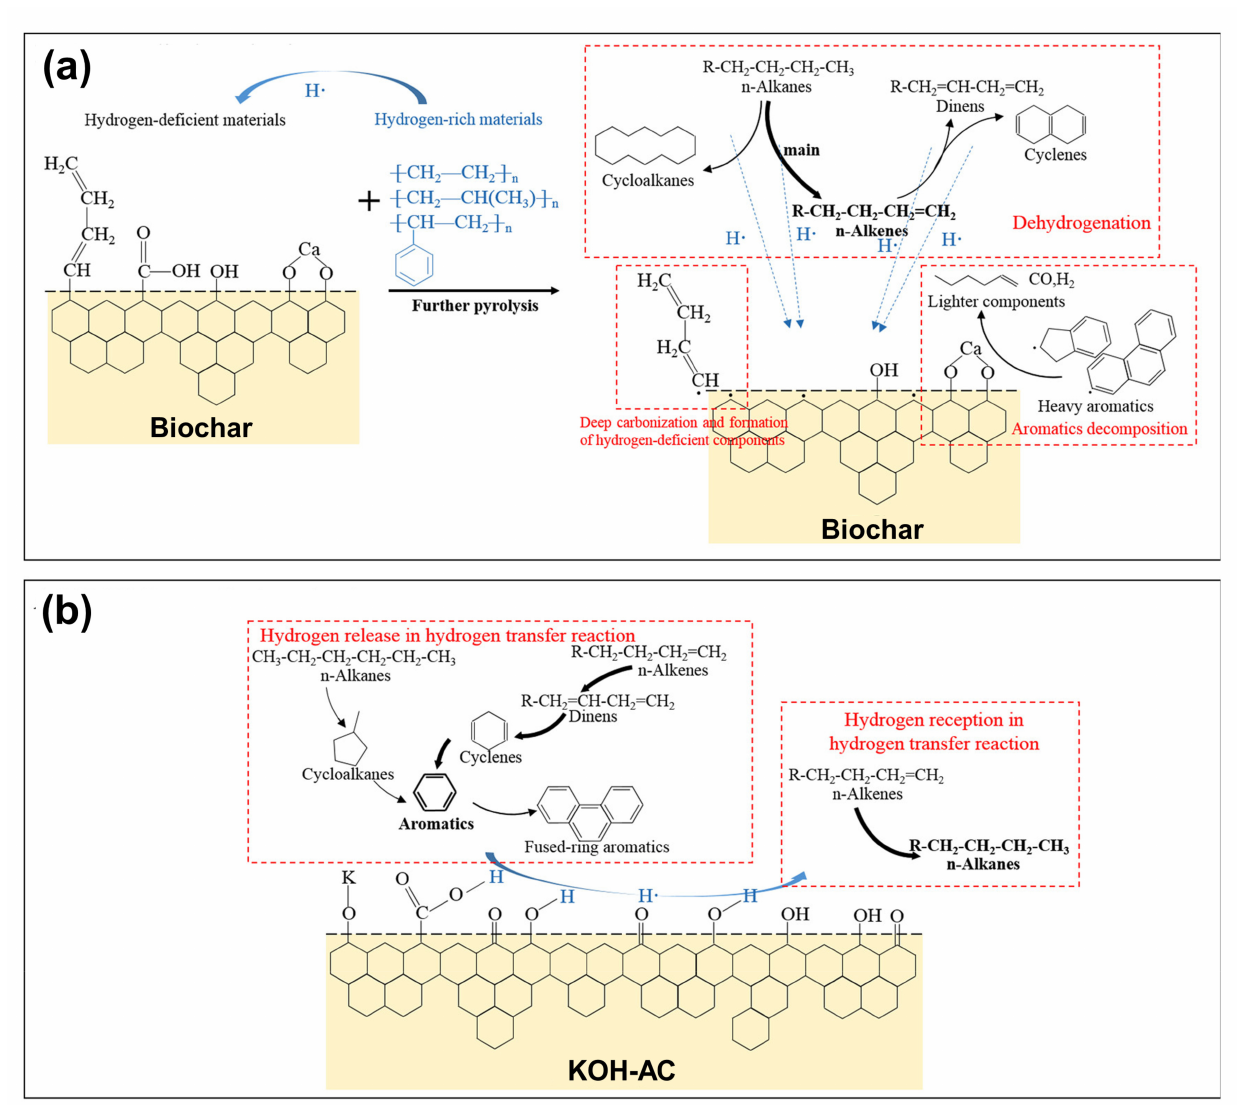
Figure 5. Catalytic mechanism of plastic with ( a ) biochar and ( b ) KOH-AC [121]. Similar to H 3 PO 4 activation, ZnCl 2 activation can also increase the acidity of AC, and Zn species can form Lewis acid sites [128]. Sun et al. [79] used AC activated by ZnCl 2 for the pyrolysis of WP mixtures (polyethylene, polyethylene, and polystyrene). The content of aromatics in the obtained liquid could reach up to 42.4%, in which bicyclic aromatics accounted for 87.7% of the total aromatics. In addition, the selectivity of 1,3- diphenylpropane in bicyclic aromatic hydrocarbons reached 37%. The presence of Zn facilitated the dehydrogenation and dehydrocyclization of alkanes and olefins, and the aromatization rate was increased through the Diels–Alder reaction, hydrogen transfer reaction, and direct dehydrocyclization. In addition, Lewis acid sites can effectively catalyze the alkylation of aromatics, resulting in the further consumption of olefins and the formation of a large number of aromatics with side chains [129]. In conclusion, ZnCl 2 activation leads to the formation of plentiful acid centers (mainly Lewis acid centers), which results in an increase in aromatic content and a decrease in olefin content in the pyrolytic oil. The catalytic mechanism of plastic with ZnCl 2 -AC is shown in Figure